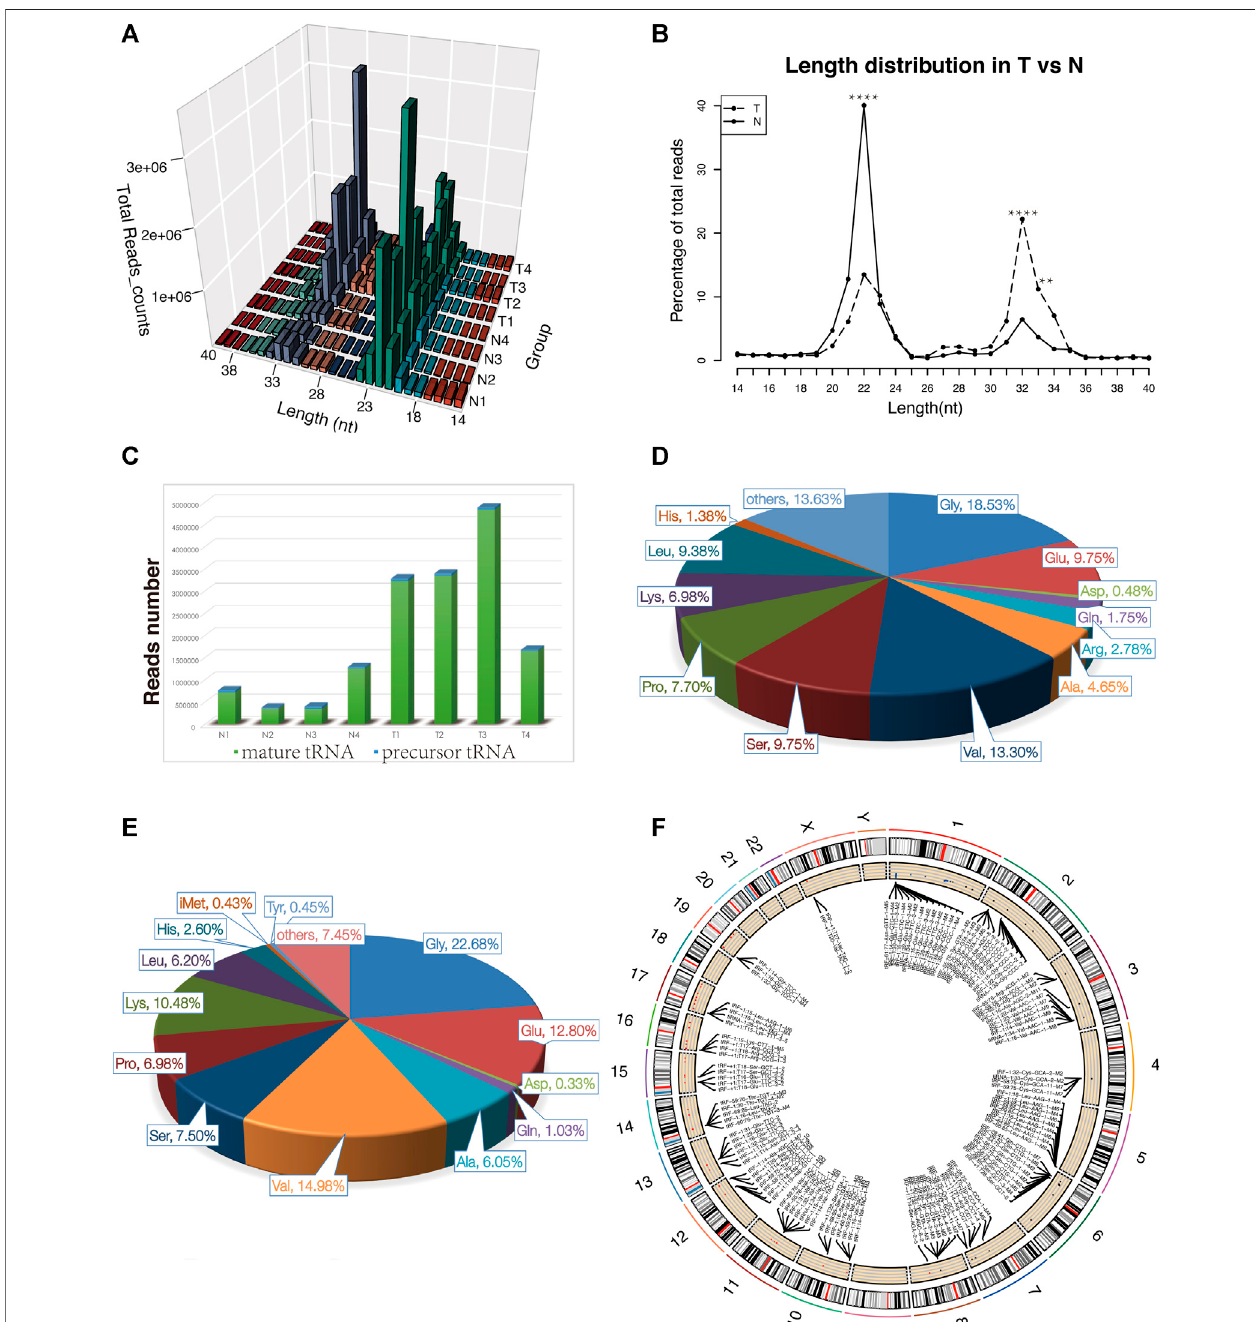
FIGURE 1 | Characteristics of the detected tsRNAs in nasopharyngeal carcinoma and healthy controls. (A) Length distribution of the detected tsRNAs. x -axis, the length of the detected tsRNAs; y -axis, the abundance of tsRNAs classi fi ed by different lengths. (B) Length of tsRNAs in NPC tumor tissuesand matched normal tissues mainly ranged from 14to 40 nt ** p < 0.01, **** p < 0.0001. (C) Reads number of the source of tRFs and tiRNAs (mature tRNA and precursortRNA). (D – E) Distribution of source tRNAs in healthy controls and nasopharyngeal carcinoma. (F) Circos plot of detected tsRNAs on human chromosomes (visualize only part of the data). Abbreviations: T, tumor specimens; N, normal